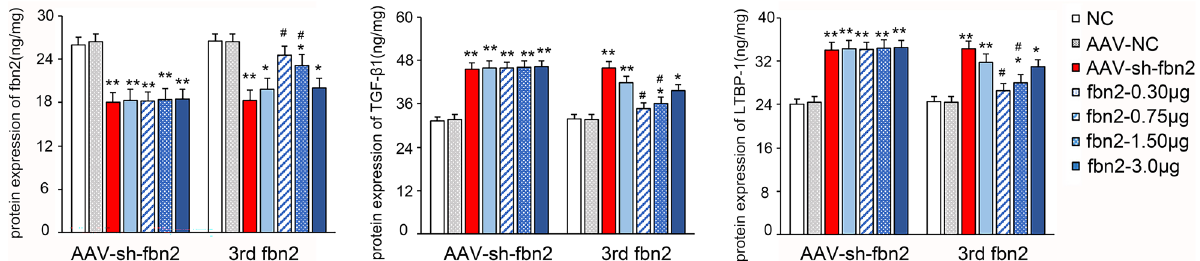
Figure 7. Elisa measurement of Fbn2, Tgf-β1 and LTBP-1 expression at protein levels in retina of mice in NC, AAV-NC, AAV-sh-fbn2, Fbn2-0.30 μg, Fbn2-0.75 μg, Fbn2-1.50 μg and Fbn2-3.0 μg group (all groups n = 9). Data are shown as mean ± SEM. * P < 0.05 all other groups versus AAV-NC group; ** P < 0.001 all other groups versus AAV-NC group; # P < 0.05 all other groups versus AAV-sh-fbn2 group. NC group: Animals without intervention. AAV-NC group: Animals with an intravitreal injection of AAV empty vector and without any further treatment. AAV-sh-fbn2 group: Animals with an intravitreal injection of AAV-sh-fbn2 and without any further treatment. Fbn2-0.30 μg group: Animals with an intravitreal injection of AAV-sh-fbn2, followed by an intravitreal injection of fbn2 recombinant protein in a dose of 0.30 μg. Fbn2-0.75 μg group: Animals with an intravitreal injection of AAV-sh-fbn2, followed by an intravitreal injection of fbn2 recombinant protein in a dose of 0.75 μg. Fbn2-1.5 μg group: Animals with an intravitreal injection of AAV-sh-fbn2, followed by an intravitreal injection of fbn2 recombinant protein in a dose of 1.50 μg. Fbn2-3.0 μg group: Animals with an intravitreal injection of AAV-sh-fbn2, followed by an intravitreal injection of fbn2 recombinant protein in a dose of 3.00 μg.